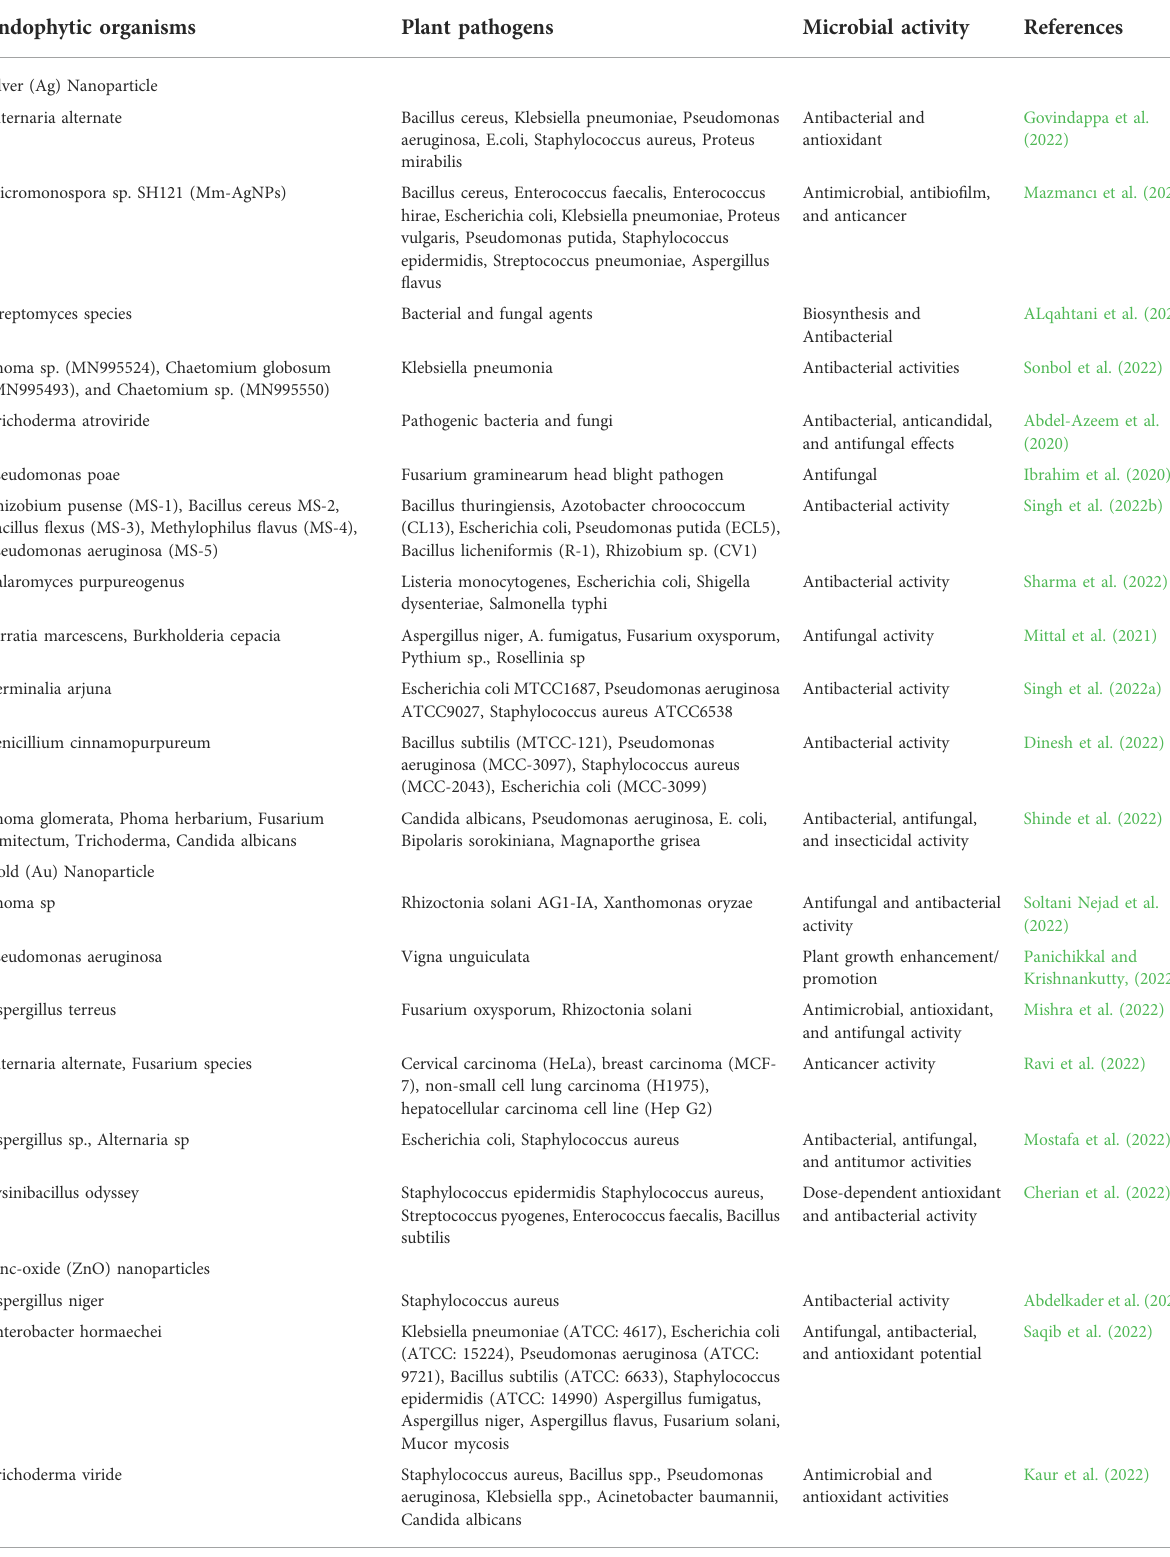
TABLE 4 The biological activities of nanoparticle-synthesizing endophytic microbes against plant